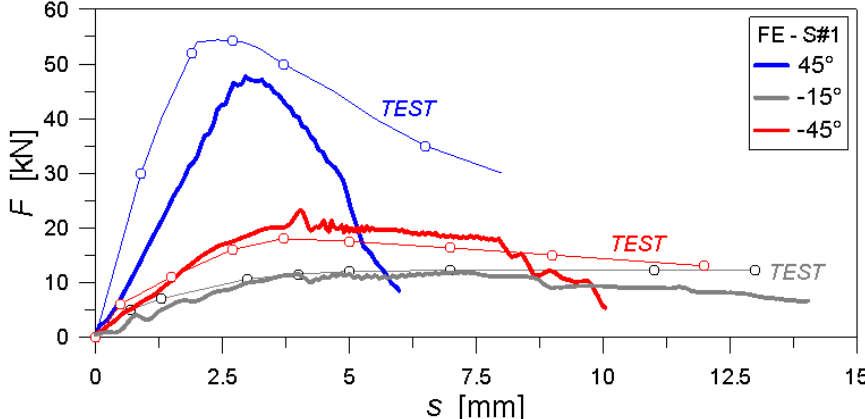
Figure 8. Force-slip curves of selected TTC joints with inclined STSs under a standard PO setup (ABAQUS/Explicit, S#1, α = var) and corresponding experimental results (data from [6]).